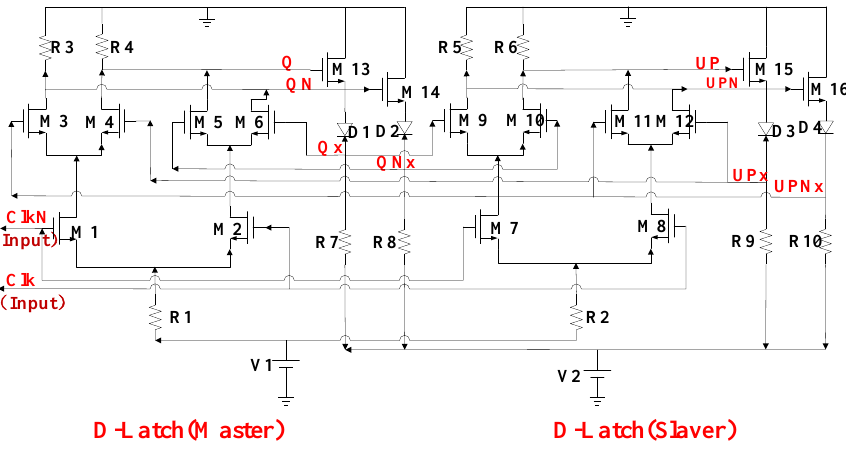
Figure 8. The structure of the static 2:1 FD.